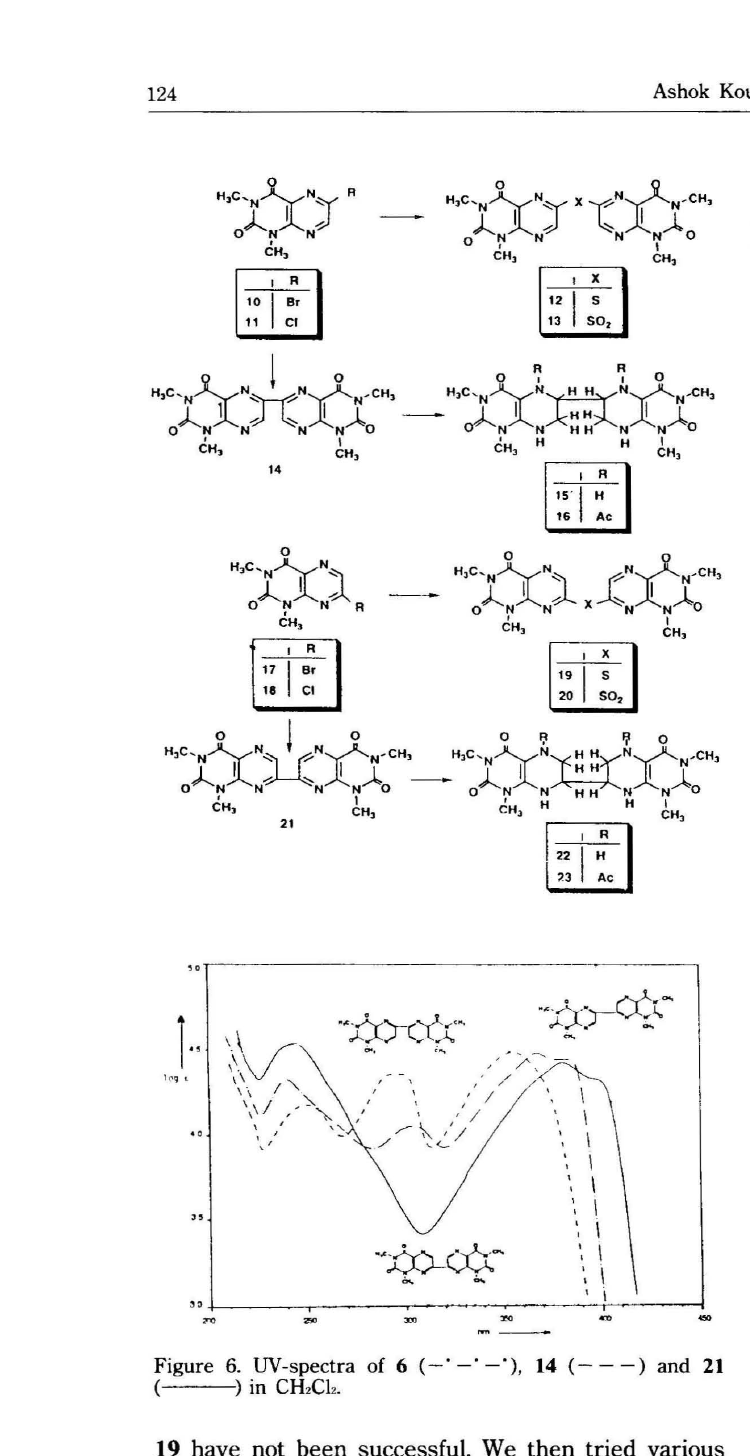
Figure 6. UV-spectra of 6 (- ' -' -"), 14 (- - -) and 21 (- --) in CH,Cb. 19 have not been successful. We then tried various direct coupling reactions with 6- (11) and 7-chloro- 1,3-dimethyllumazine (18), respectively, starting